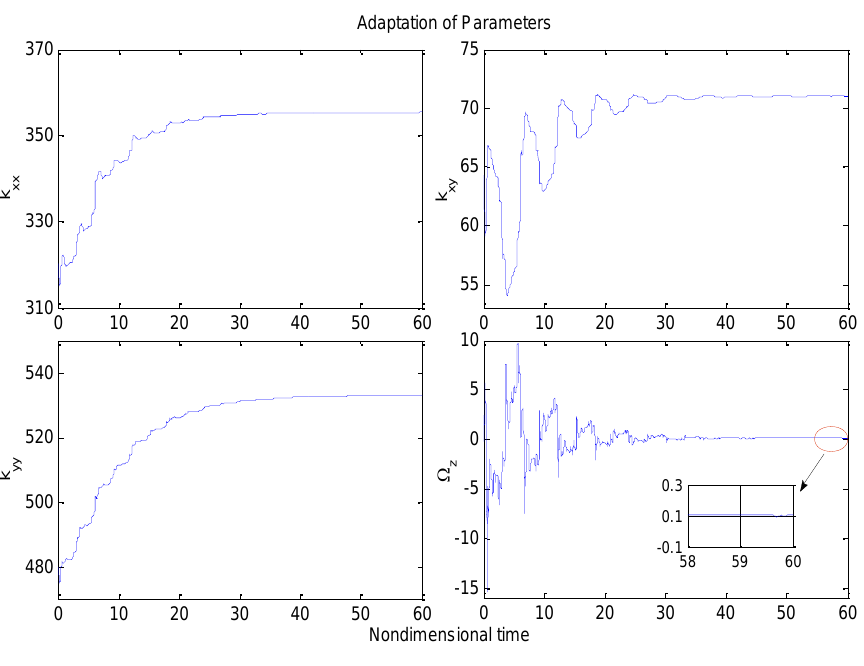
Figure 5. Adaptive parameter estimates using ABC.